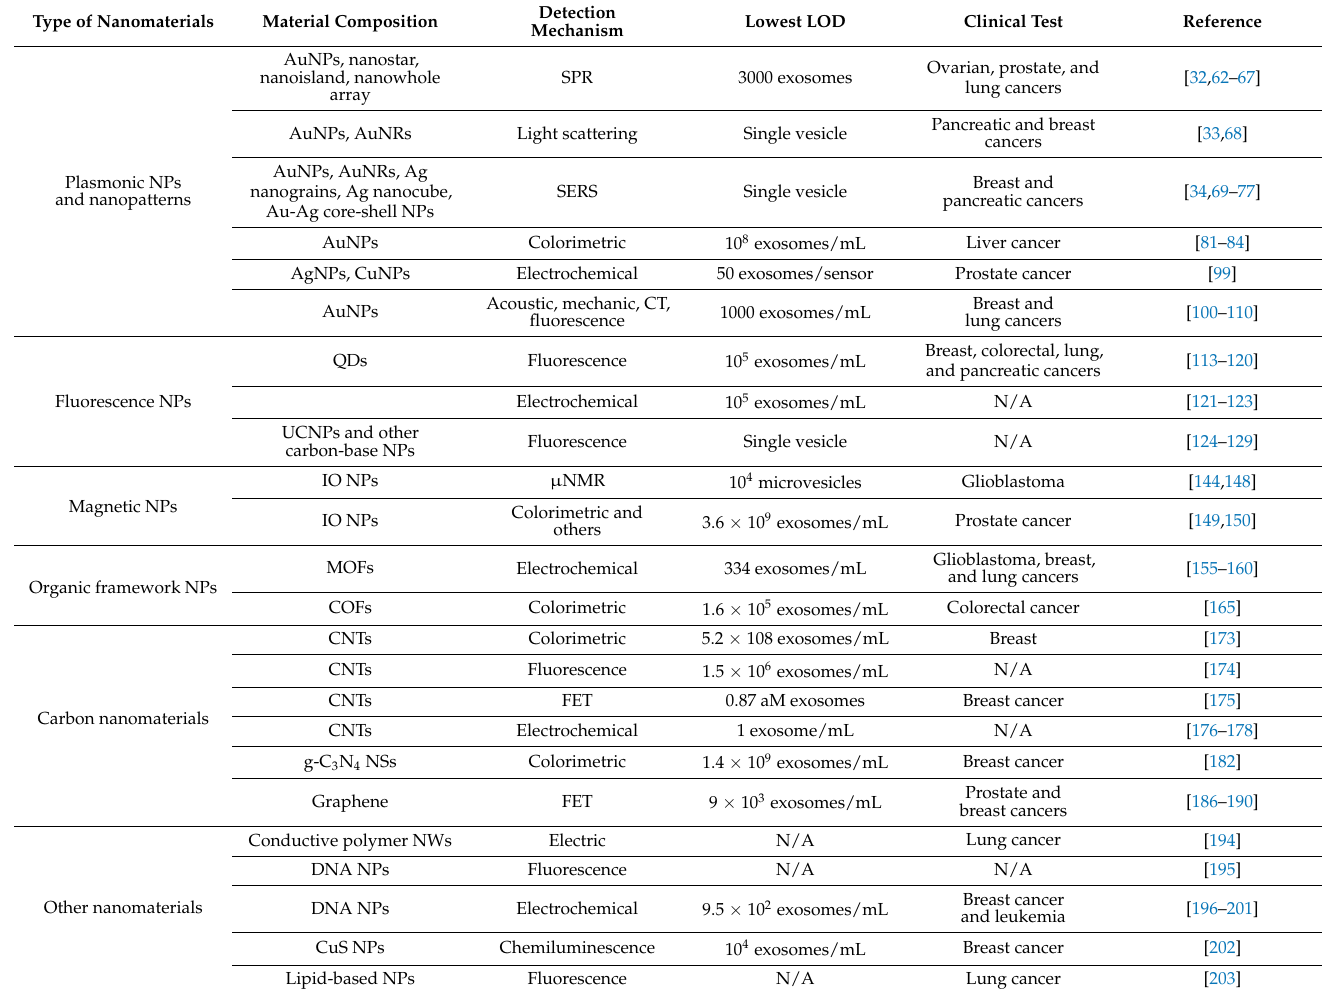
Table 1. Summary of the major nanomaterials for molecular detection and analysis of extracellular